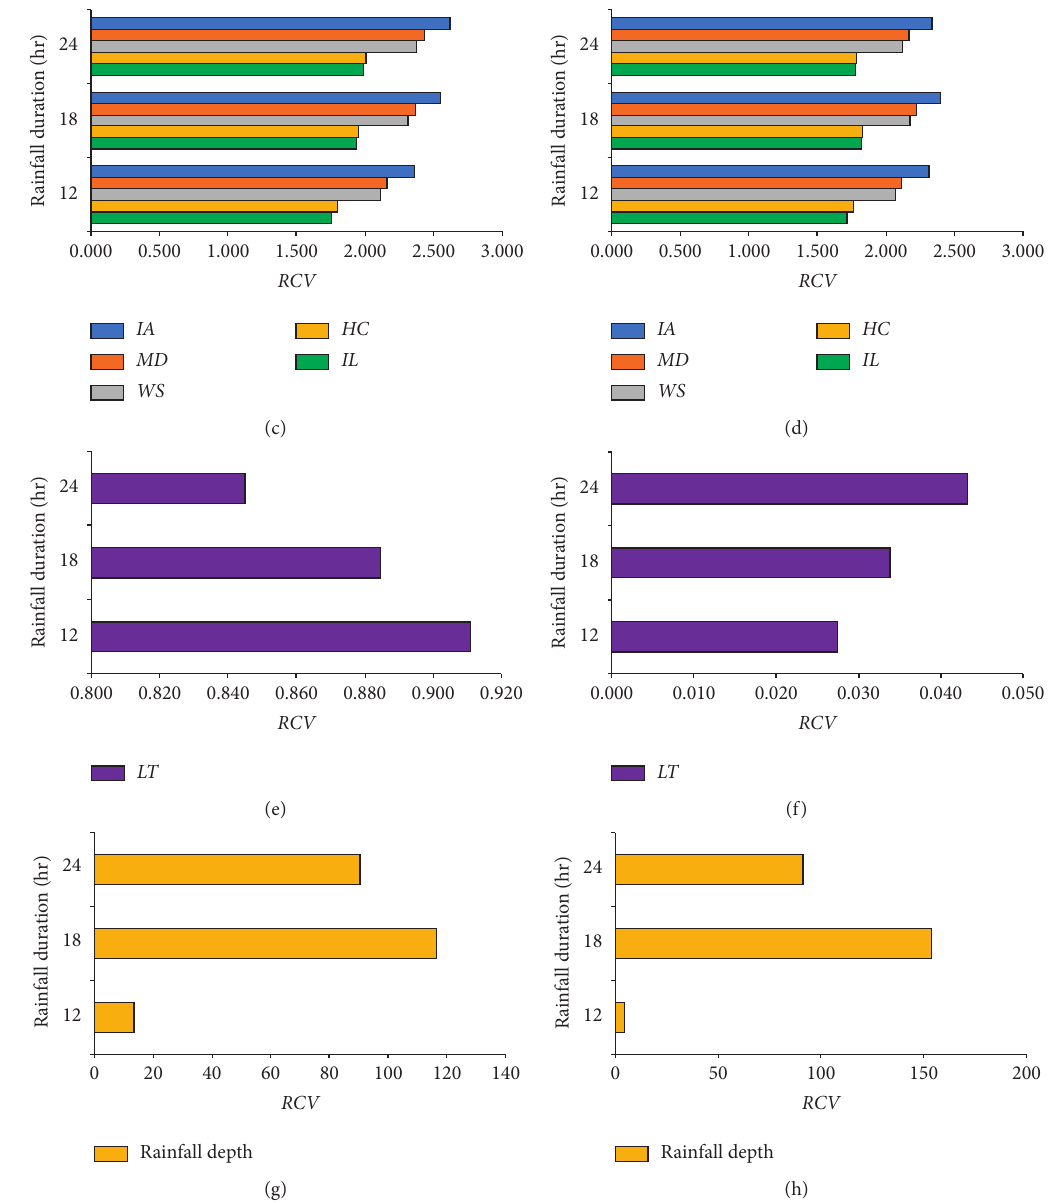
Figure 4: The impact of uncertainty in (a) base flow parameters on peak discharge, (b) base flow parameters on flood volume, (c) loss parameters on peak discharge, (d) loss parameters on flood volume, (e) unit hydrograph parameters on peak discharge, (f) unit hydrograph parameters on flood volume, (g) rainfall depth on peak discharge, and (h) rainfall depth on flood volume for different rainfall